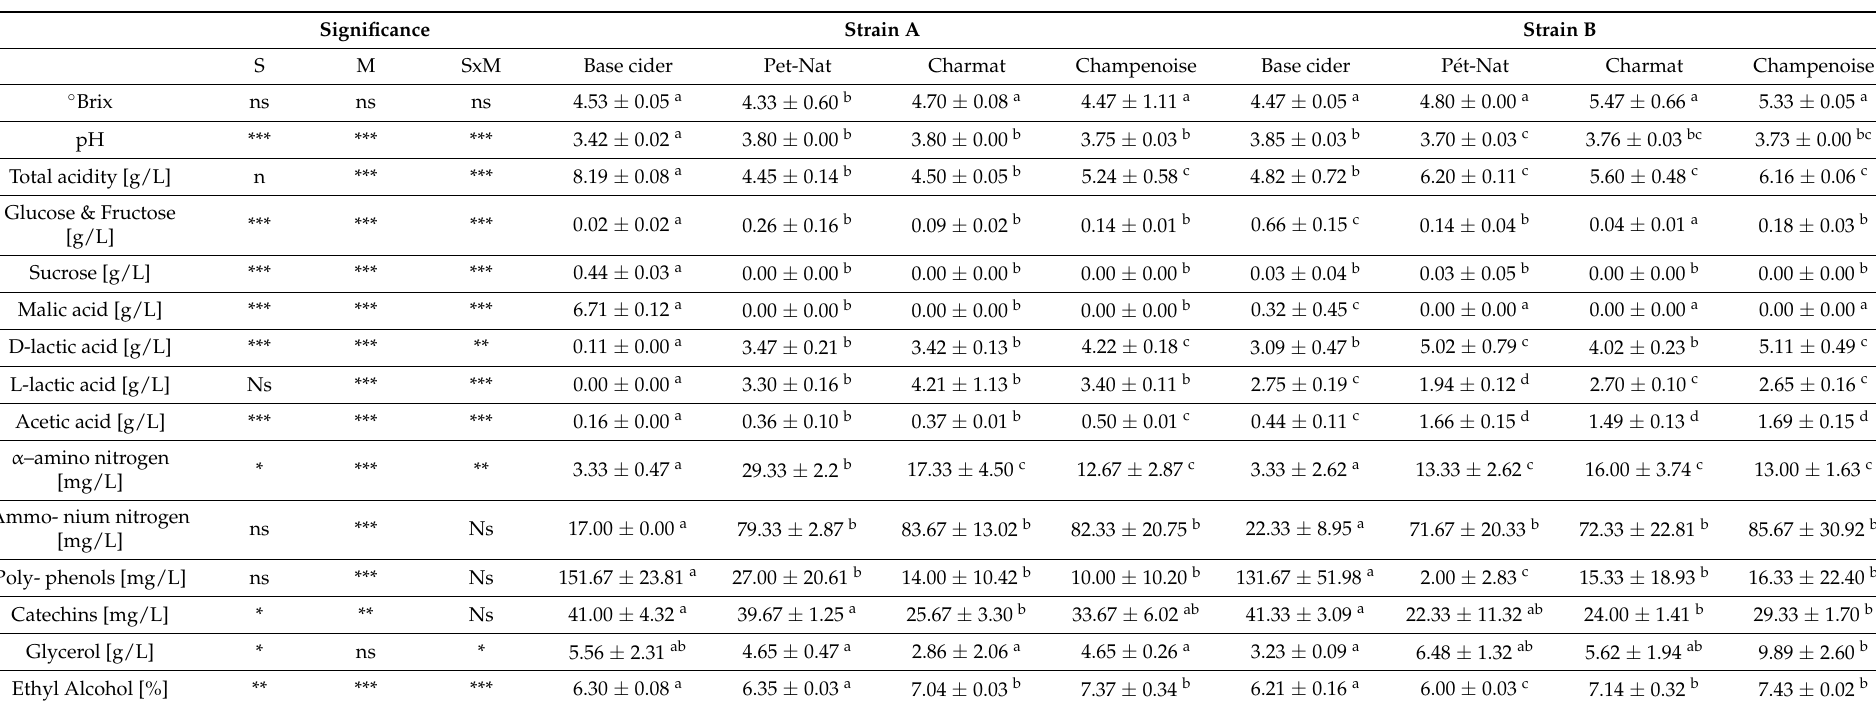
Table 1. Physicochemical characteristics of ciders produced with two different strains of T. delbrueckii and different fermentation methods aimed to produce sparkling